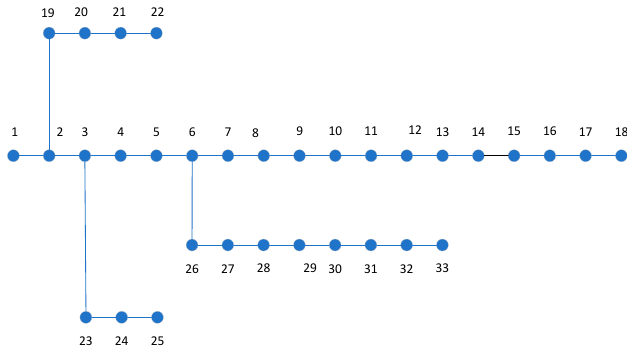
Figure 6. Topological structure of road network.